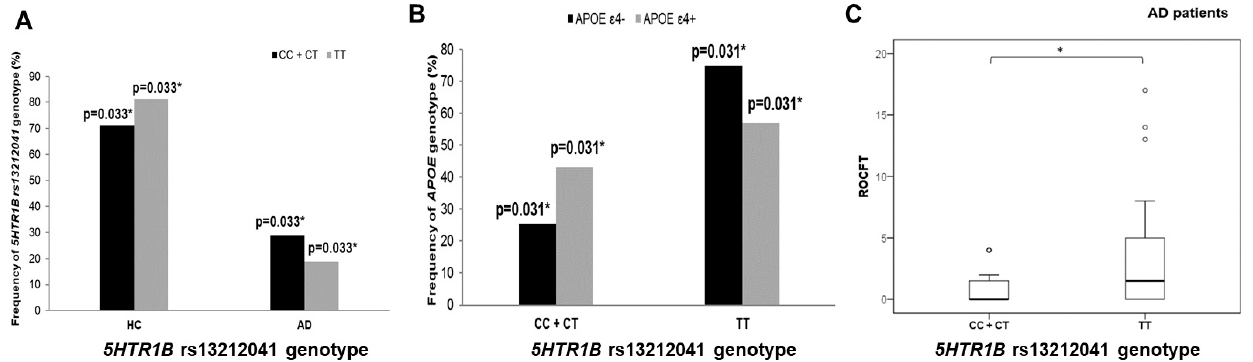
Figure 3. Participants carrying the C allele within 5HTR1B rs13212041 polymorphism are ( A ) more represented among AD patients, ( B ) have higher frequency of APOE ɛ 4 carriers (in males older than 65 years of age), and ( C ) show poorer performances on ROCFT test. * p < 0.05. A significantly higher number of APOE ɛ 4 allele carriers was also observed among individuals carrying the T allele within the 5HTR6 rs1805054 (C267T) polymorphism ( χ 2 = 6.425, df = 1; p = 0.011; Figure 4).